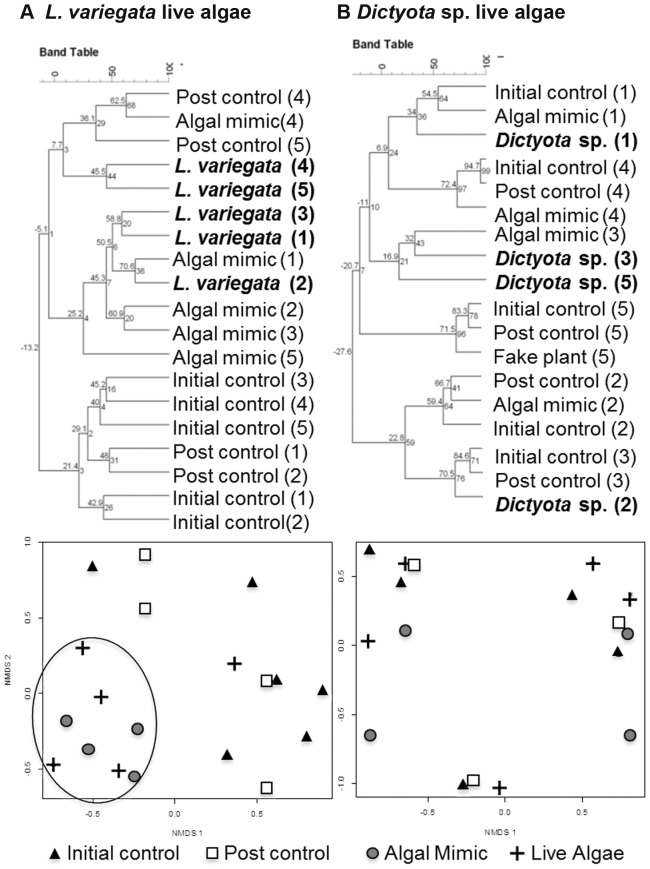
Results for live algae application.Hierarchical cluster analyses showing similarity among microbial samples (%; inner tree) with bootstrap support (1000 iterations, outer tree) to examine the effect of live macroalgae in the genera: A. L. variegata and B. Dictyota sp. applied to M. faveolata coral colonies in Belize 2009. Numbers in parentheses correlate to the experimental colony (#1–5). Results are further illustrated by nMDS plots of each coral-algal pair.